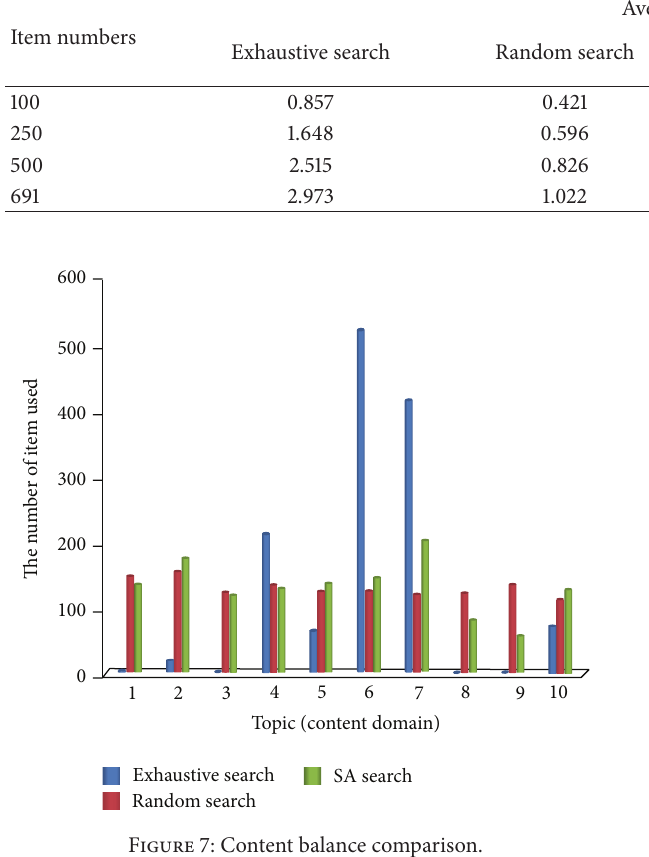
Figure 7: Content balance comparison.